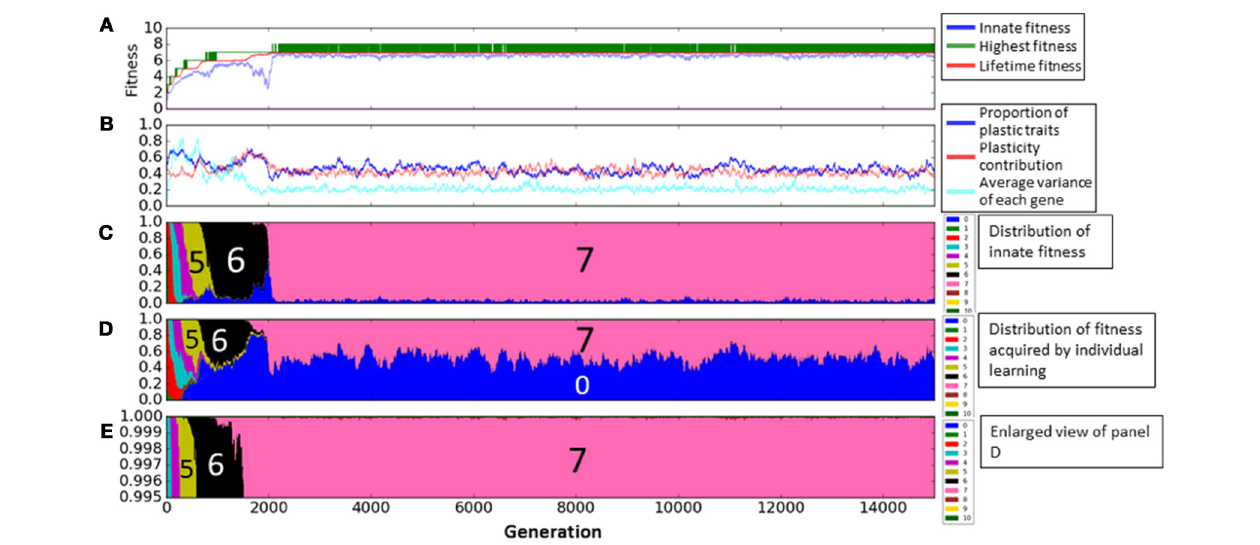
FIGURE 4 | The evolution of the population with individual learning. (A) Shows the initial and highest and lifetime fitness, and (B) shows the proportion of plastic traits, plasticity contribution and average variance of each gene. (C) Shows the distribution of the innate fitness. (D) Shows the distribution of acquired step fitness by individual learning, and (E) shows the enlarged view of (D) , when agents doing only individual